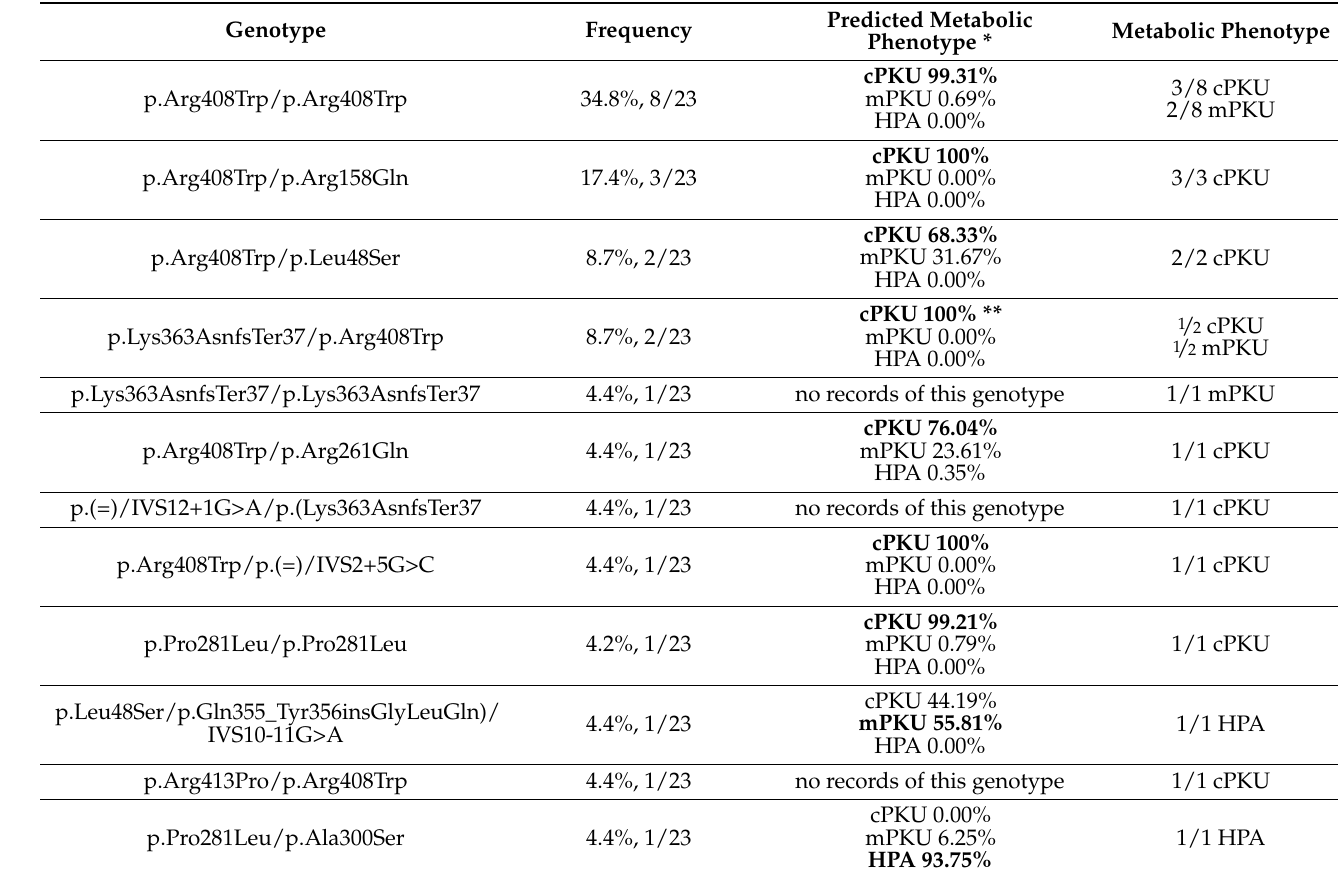
Table 3. Metabolic phenotype for our North-Western Romania patient group.